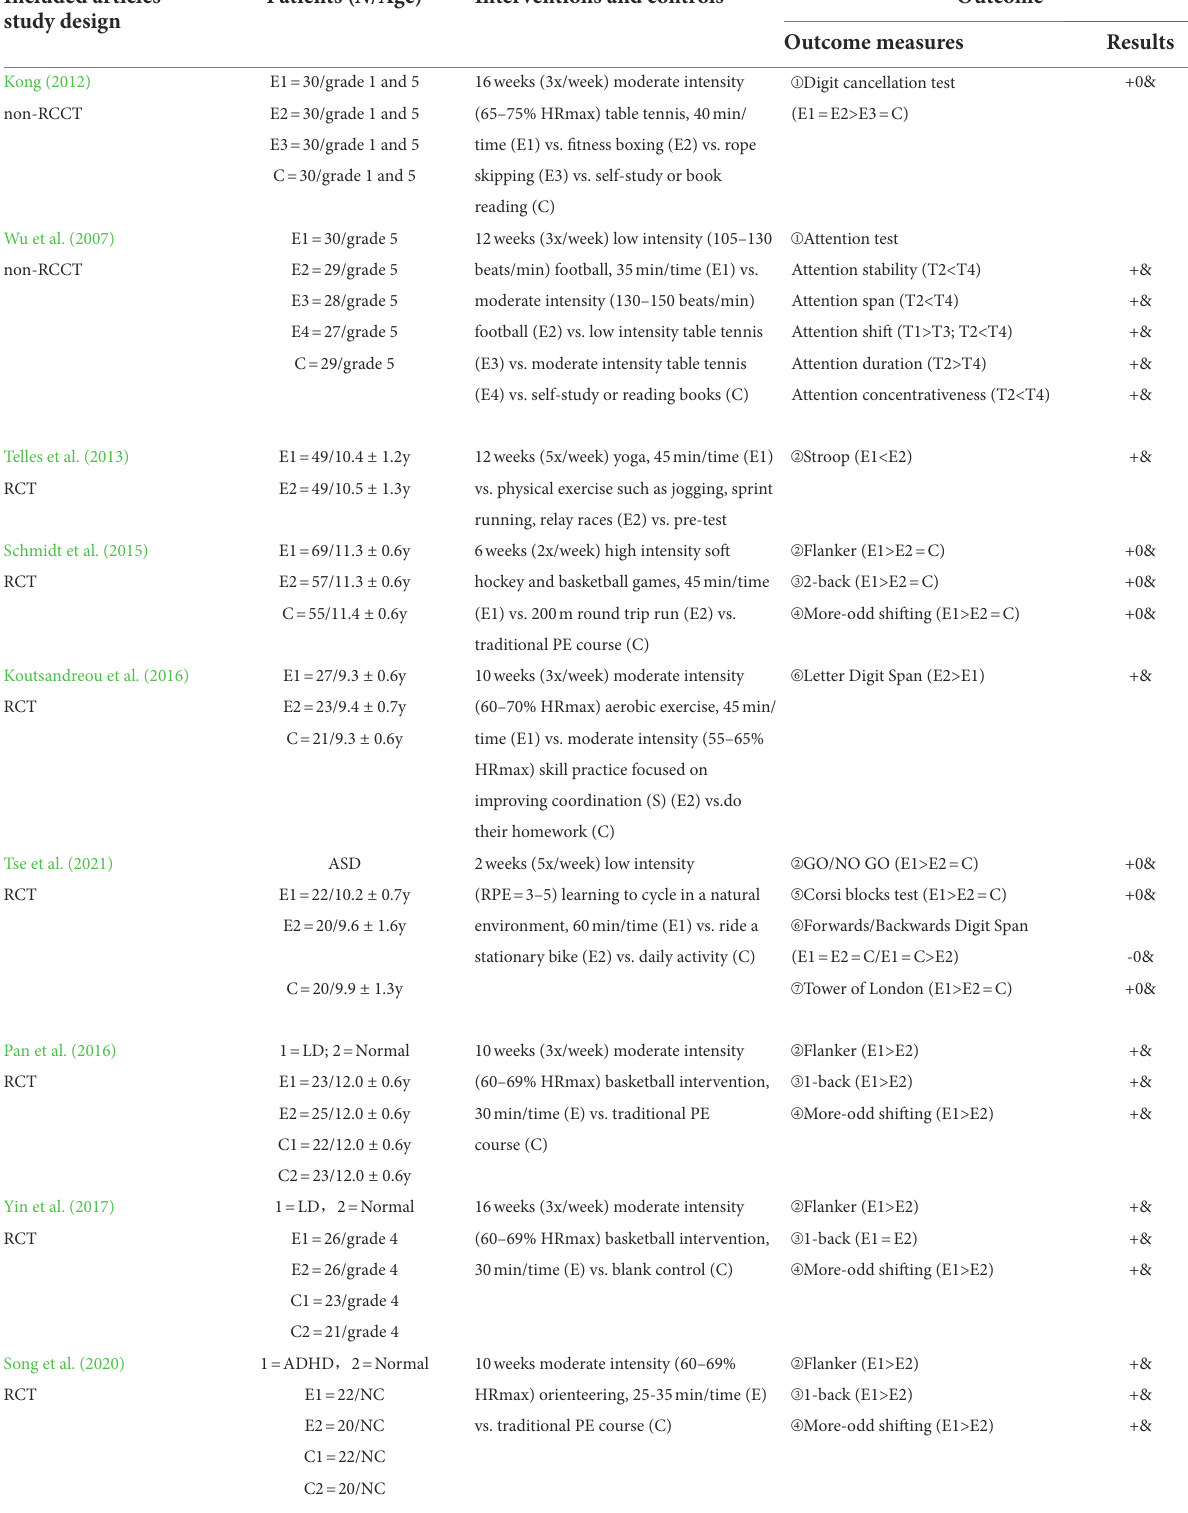
TABLE 2 Comparative study of long-term interventions of motor skills on the cognition of children and adolescents. Included articles Patients ( N /Age) Interventions and controls Outcome study design